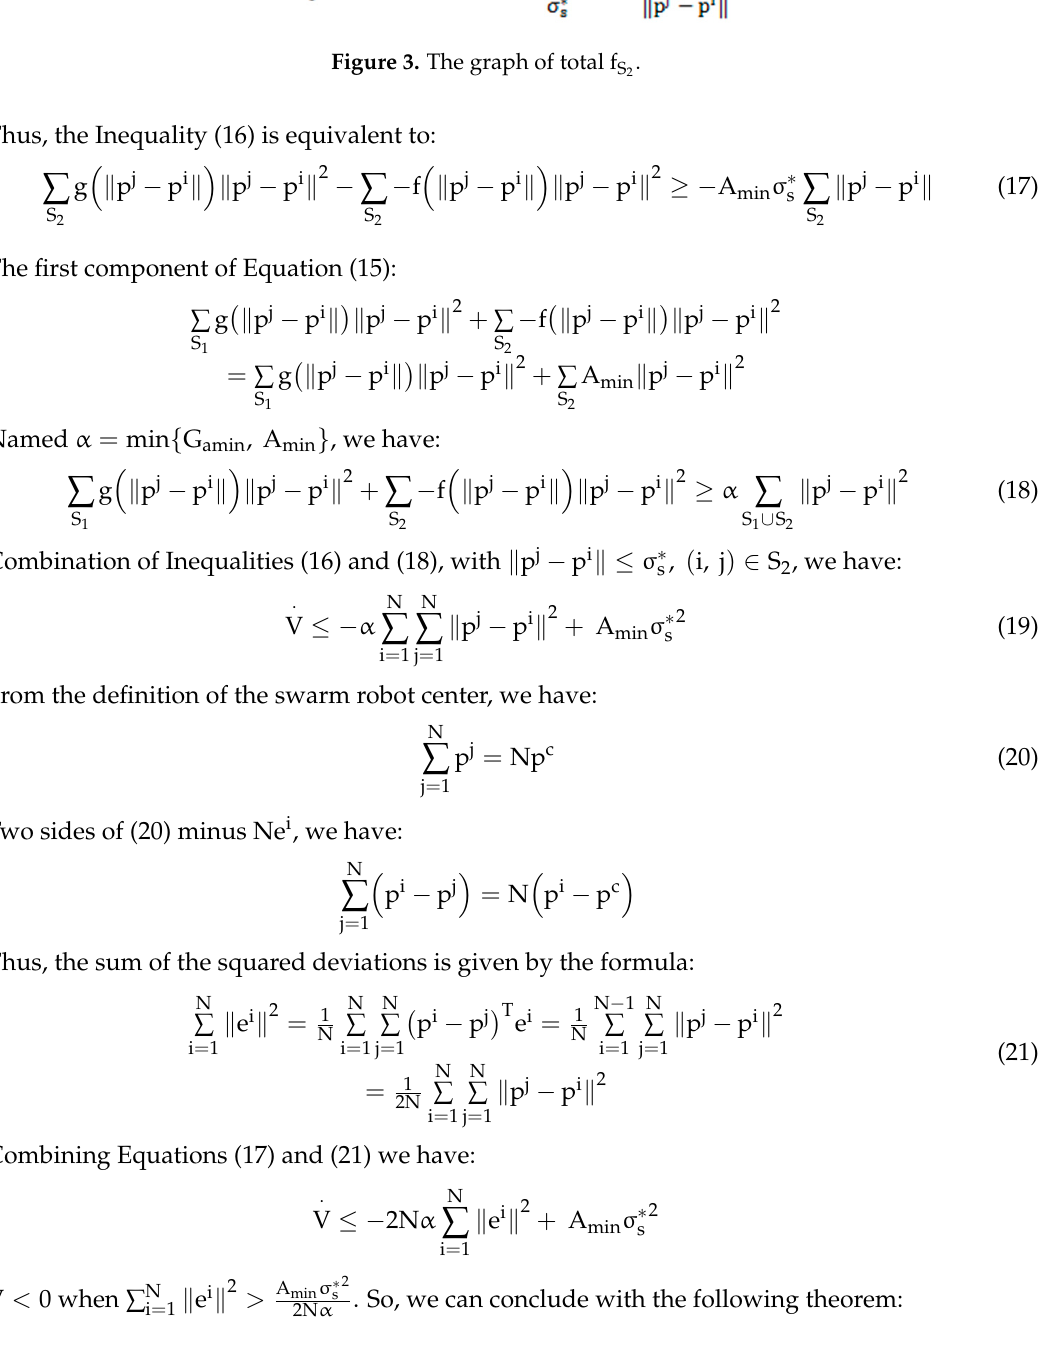
Figure 3. The graph of total f (cid:2903)